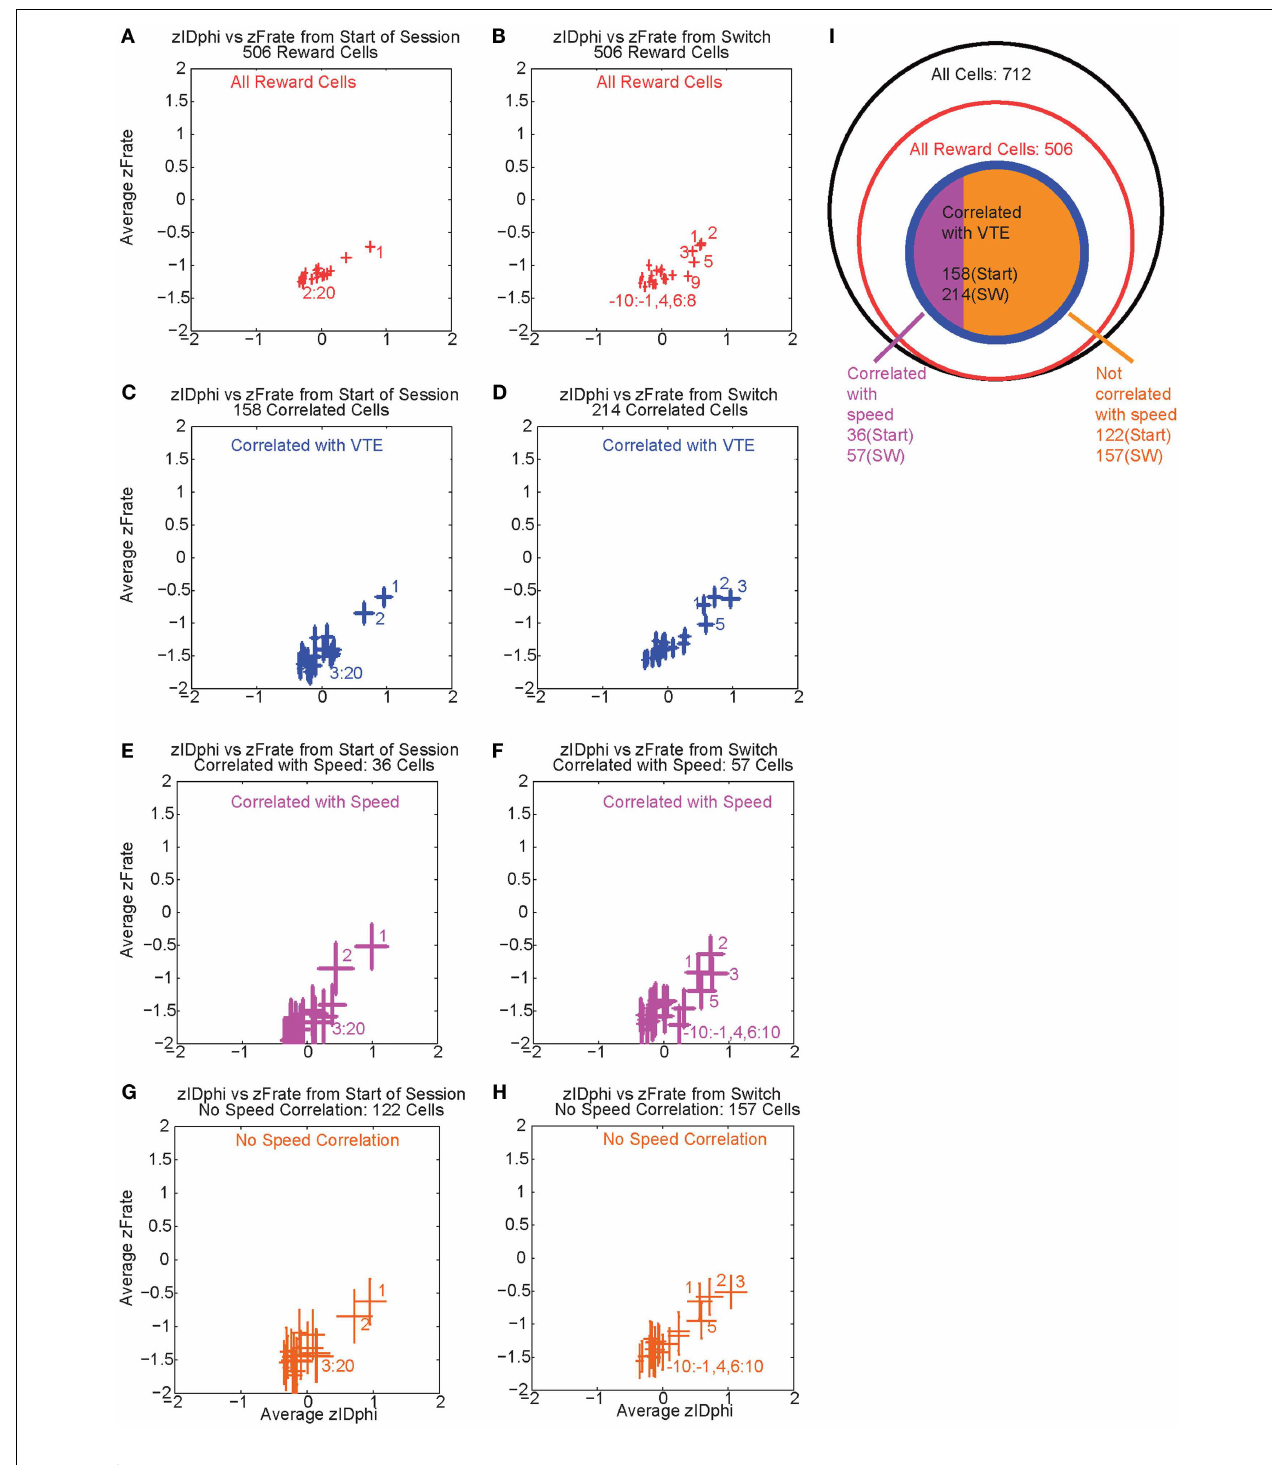
FIGURE 9 | Firing rate and zIdphi relationships. For each reward responsive cell, the average firing rate through a pass acrossT4 was calculated. A total of 506 cells responded significantly to reward.We then z -scored that firing rate distribution for each cell, producing a zFRate measure for each cell for each pass. Each panel shows the average zFRate across cells for each lap as a function of zIdPhi for that lap. Left panels used lap numbers aligned to the start of the session. Right panels used lap numbers aligned to the switch in